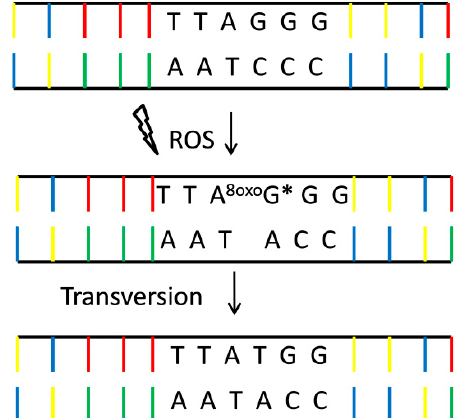
Figure 6. Mutagenicity of 8-oxoGua. 8-oxoGua—one of the most common DNA lesions resulting from ROS modification of guanine and leading to mismatched pairing with adenine, resulting in G to T and C to A substitutions in the genome. *~10,000 8-oxoGua residues per single nucleus of a human cell [87].